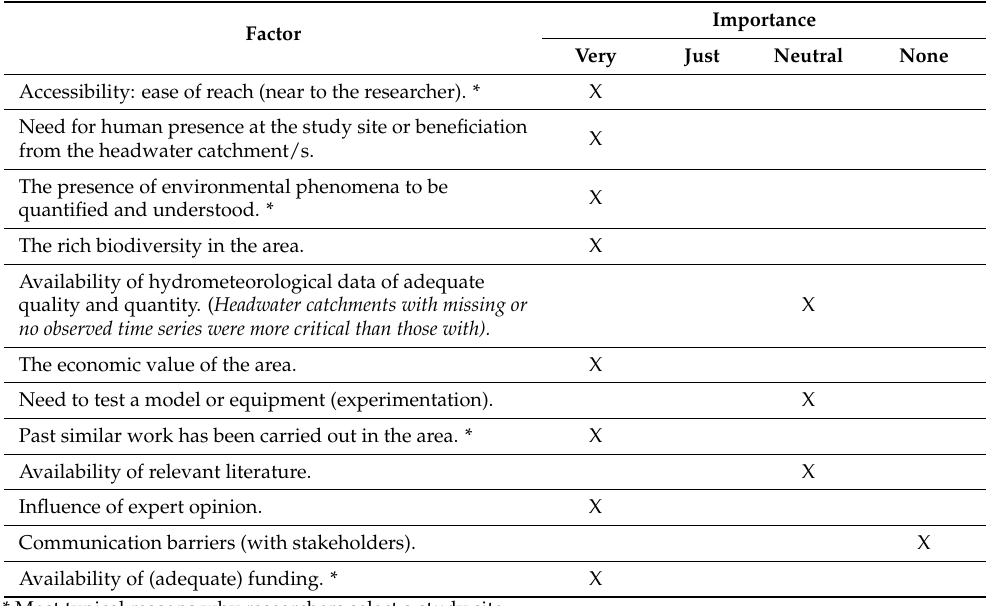
Table 2. Factors influencing the choice of a study site and their level of importance in the intended study. X marks the importance of the factor.